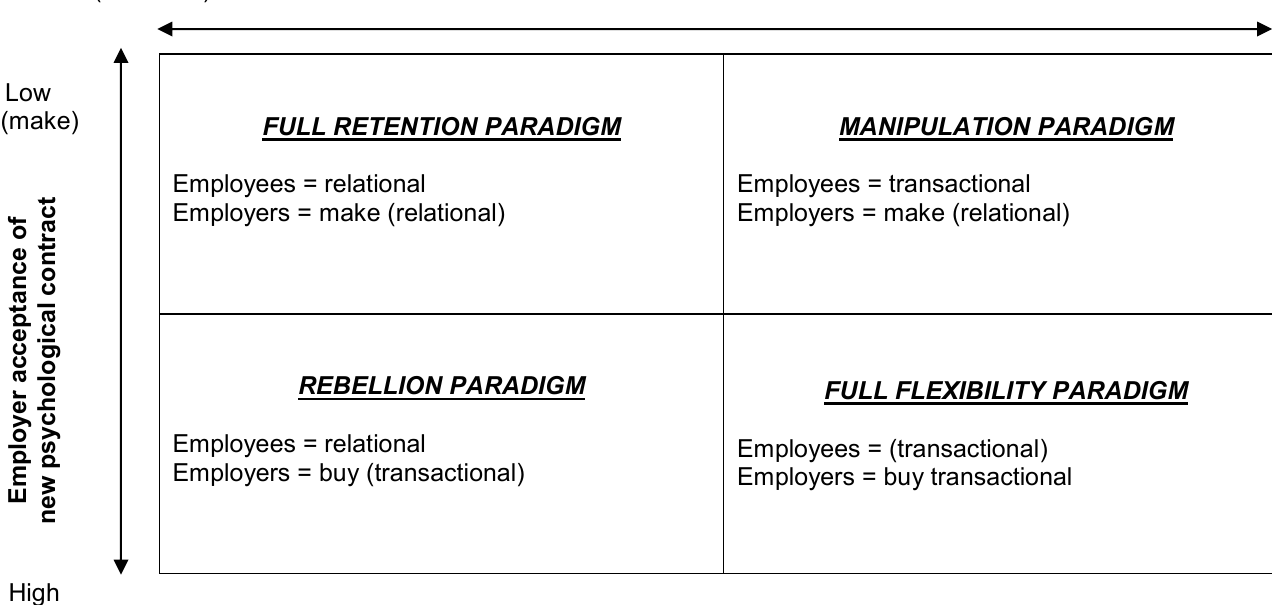
Figure 1: Contingency model of key employee retention looked at an employee and employer exchange obligations from the specific viewpoint of the employee’s